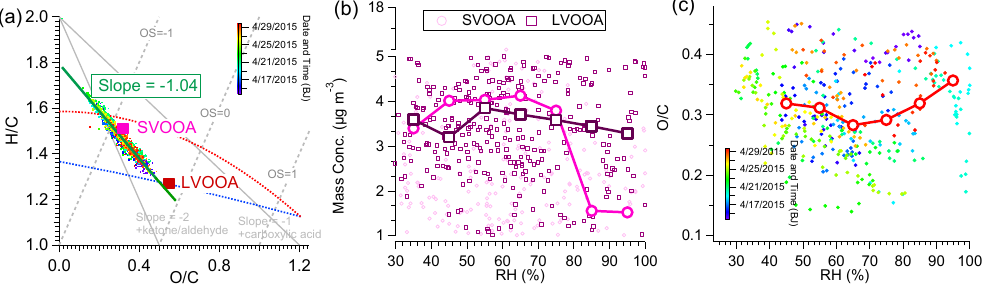
Figure 12. (a) Van Krevelen diagram of H / C vs. O / C ratios for all OA data colored by time, the blue and red dashed lines correspond to the right and left gray dashed lines in the f 44 vs. f 43 triangle plot of Fig. 8; the gray lines represent the addition of a particular functional group to an aliphatic carbon (Heald et al., 2010); (b) scatter plot of SVOOA and LVOOA mass concentrations vs. RH, the circles and squares represent the average mass concentrations within different RH bins (10% increment) for SVOOA and LVOOA, respectively; (c) scatter plot of O / C vs. RH (colored by time), the circles represent the average O / C values within different RH bins (10%